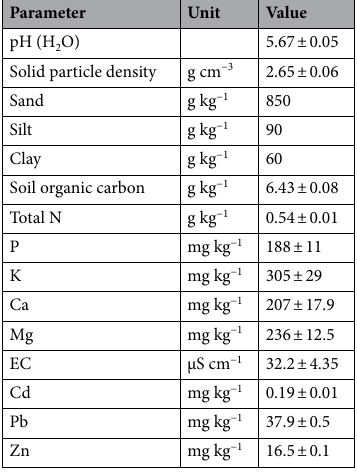
Table 1. Basic soil physical and chemical properties (means ± standard